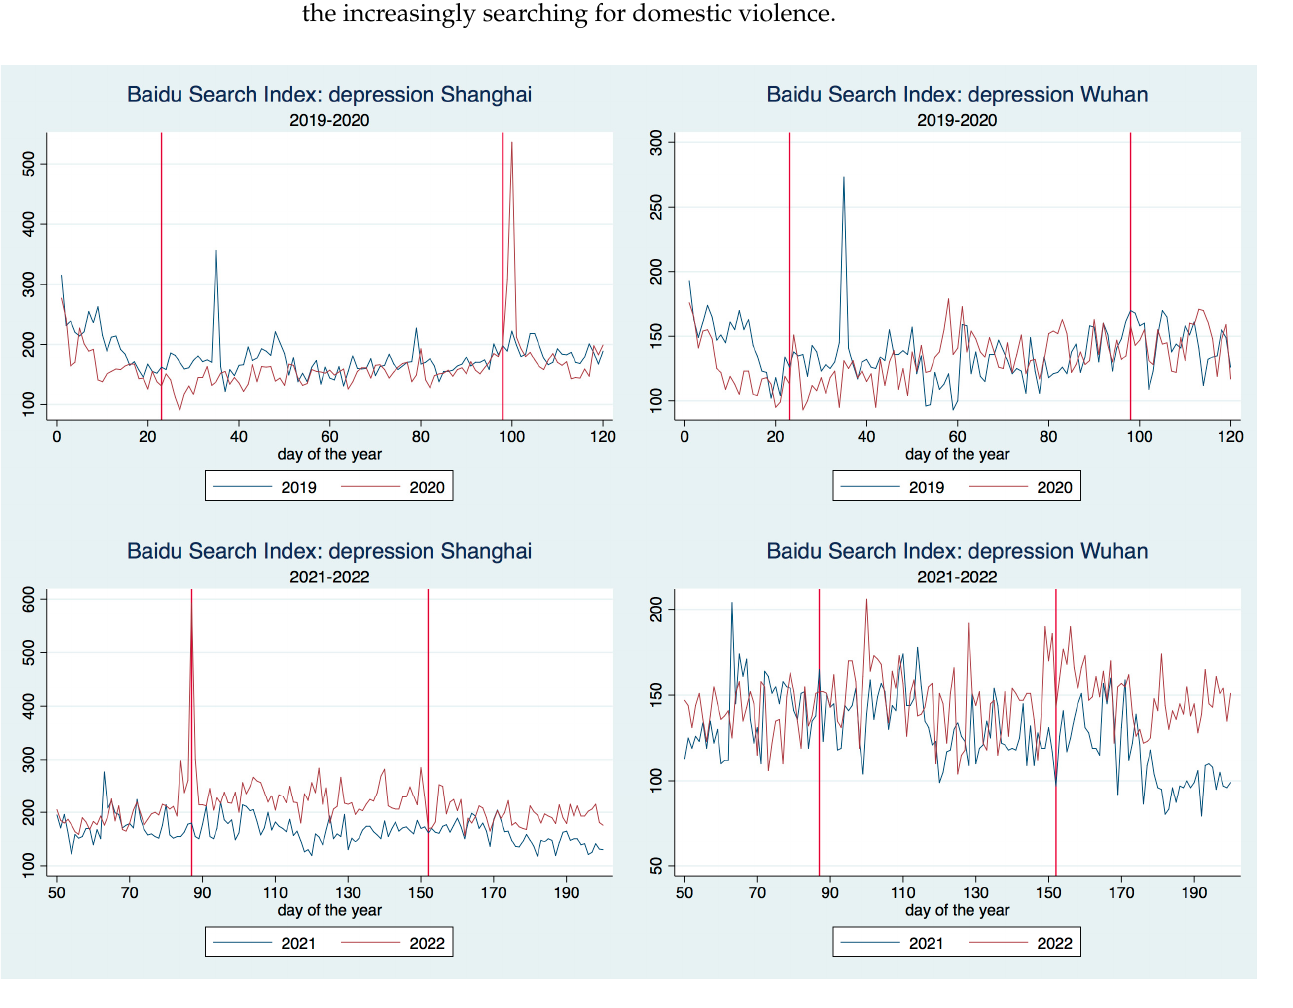
Figure 2. BSI trend for depression-related topic, Shanghai vs. Wuhan, 2019–2022.